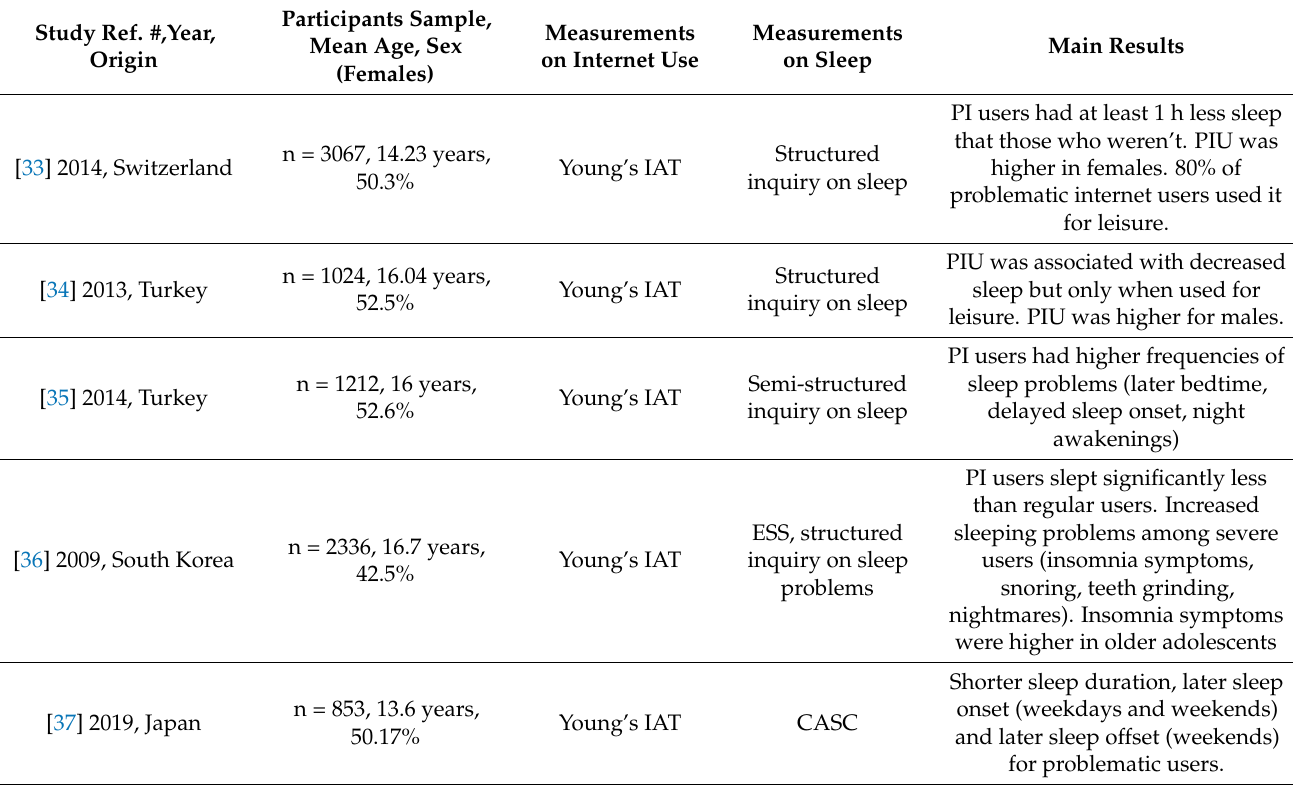
Table 2. Characteristics of included